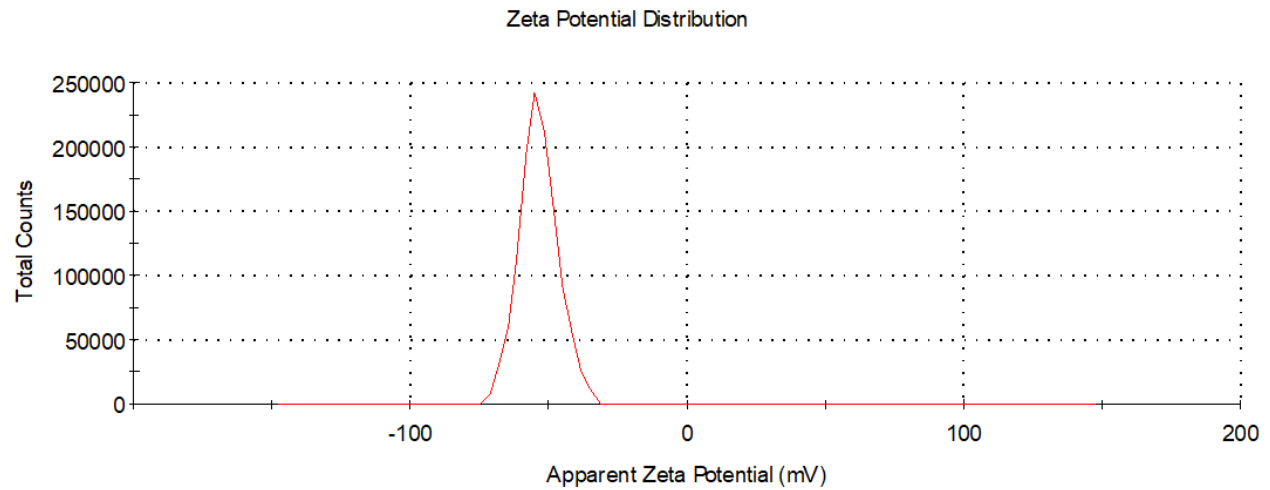
Figure 9. Zeta potential distribution of Ag-TiO 2 nanoparticles via DLS. The suspension pH was equal to 7.4.